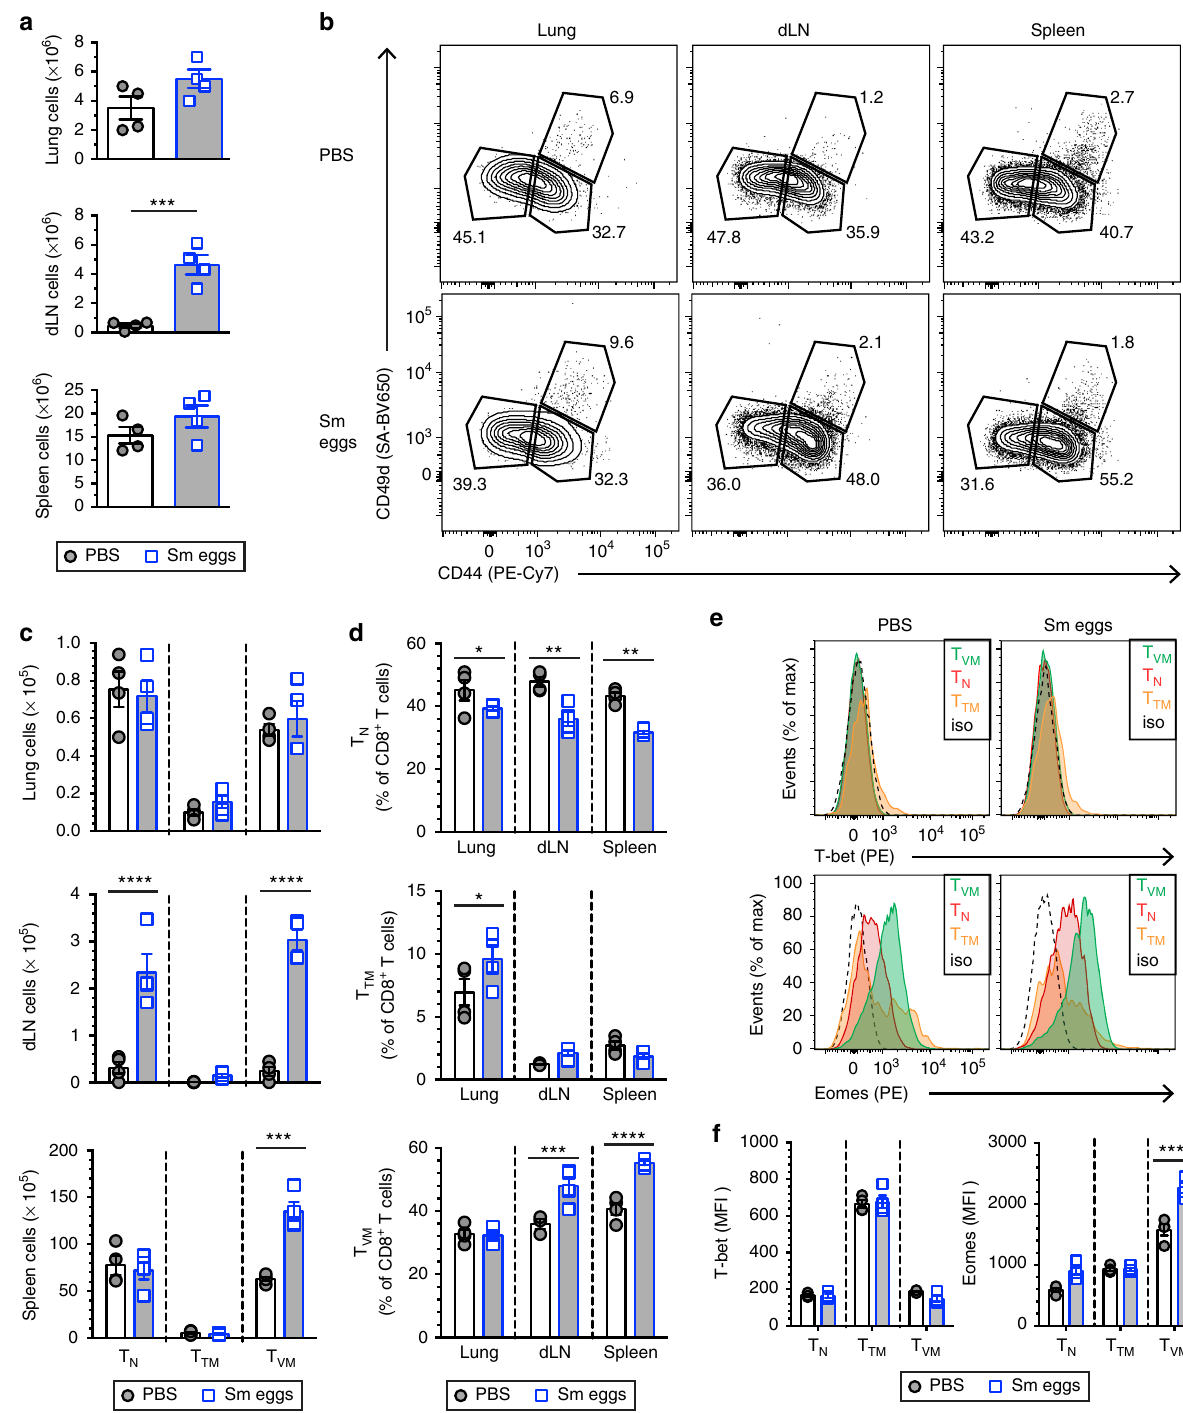
Fig. 1 S. mansoni eggs induce CD44 hi CD49d lo CD8 + T cell expansion in the draining LN and spleen. BALB/c mice were injected with S. mansoni (Sm) eggs i. p. and challenged i.v. (5000 per injection) at d14 before analysis at d22. a Absolute cell number at d22 in the indicated tissue. b Representative fl ow contour plots of gated CD8 + T cells of the indicated tissue at d22. Numbers indicate percent of events in each gate. c Cell number of CD44 lo (naive T cells, T N ), CD44 hi CD49d hi (true memory T cells, T TM ) and CD44 hi CD49d lo (virtual memory, T VM ) CD8 + T cells as determined by fl ow cytometric analysis. d Percentage of CD44 lo T N , CD44 hi CD49d hi T TM and CD44 hi CD49d lo T VM cells in CD8 + T cells as determined by fl ow cytometric analysis. e Representative histograms of PBS- or Sm egg-treated spleen CD8 + T cells. Gates were placed on CD44 lo T N , CD44 hi CD49d hi T TM and CD44 hi CD49d lo T VM cells. Flow histograms show respective expression of Eomes and T-bet. f Median fl uorescence intensities (MFI) of T-bet and Eomes at day 22 from the indicated populations after Sm egg injection. Statistical signi fi cance calculated using two-way analysis of variance (ANOVA) and Dunnett ’ s (PBS as reference mean) or Sidak ’ s multiple-comparison test ( ** P < 0.01, *** P < 0.001, **** P < 0.0001). Data are representative of three independent experiments with 4 mice per group (mean ± s.e.m. in a , c , d , f